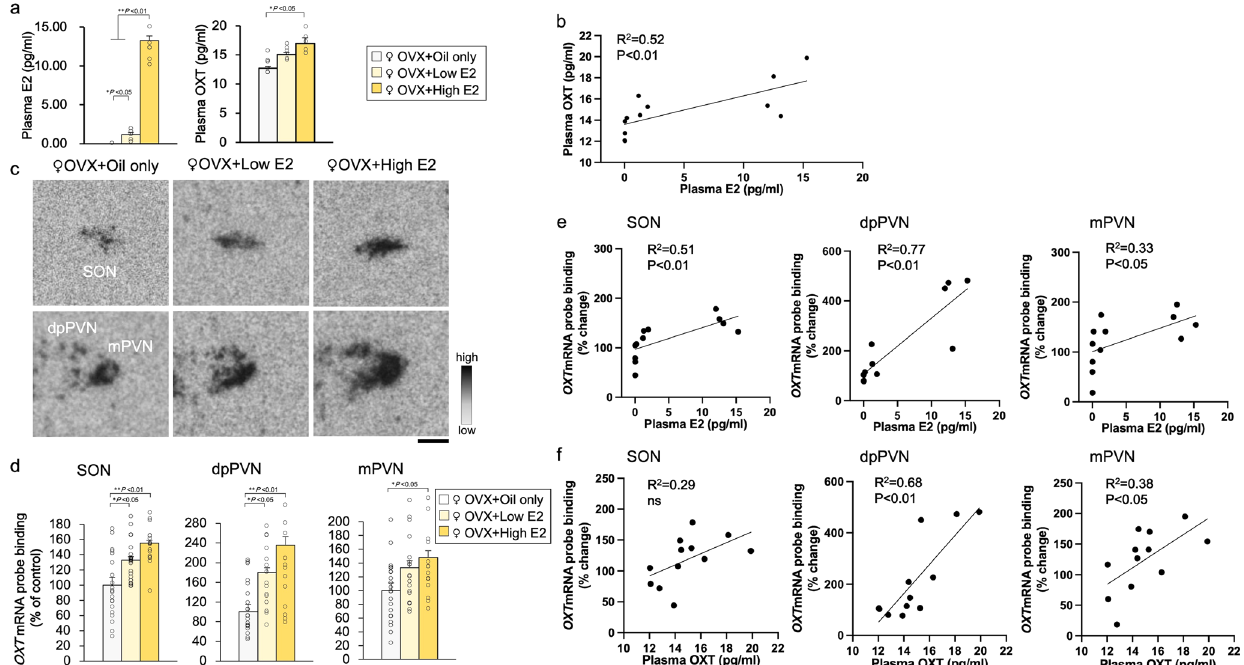
Fig. 5 Effects of oestrogen replacement on OXT gene expression. a Plasma E2 and OXT concentrations (OVX + oil-only [ n = 4], OVX + low E2 [ n = 4] and OVX + high E2 [ n = 4]). The data are presented as the mean ± SEM (one-way ANOVA) ( ** P < 0.01, * P < 0.05, compared with OVX + oil-only group). b Regression analysis for plasma E2 and OXT. The regression line and probability value for the slope are shown. The statistical signi fi cance of the slope was set at P < 0.05. c Representative images hybridised with a 35S-labelled oligodeoxynucleotide probe complementary to OXT in the SON, dp PVN, and mPVN of female OXT-mRFP1 transgenic rats in the OVX + oil-only ( n = 6), OVX + low E2 ( n = 6), and OVX + high E2 ( n = 6) groups, respectively. Scale bar indicates 100 μ m. d OXT mRNA of the SON, dpPVN and mPVN of the rats (OVX + oil-only, OVX + low E2, and OVX + high E2). The data are presented as the mean ± SEM (one-way ANOVA) ( ** P < 0.01, * P < 0.05, compared with OVX + oil-only group). e Regression analysis for plasma E2 and changes in OXT mRNA levels in the SON, dpPVN, and mPVN. The regression line and probability value for the slope are shown. The statistical signi fi cance of the slope was set at P < 0.05. f Regression analysis for plasma OXT and changes in OXT mRNA levels in the SON, dpPVN, and mPVN. The regression line and probability value for the slope are shown. The statistical signi fi cance of the slope was set at P <